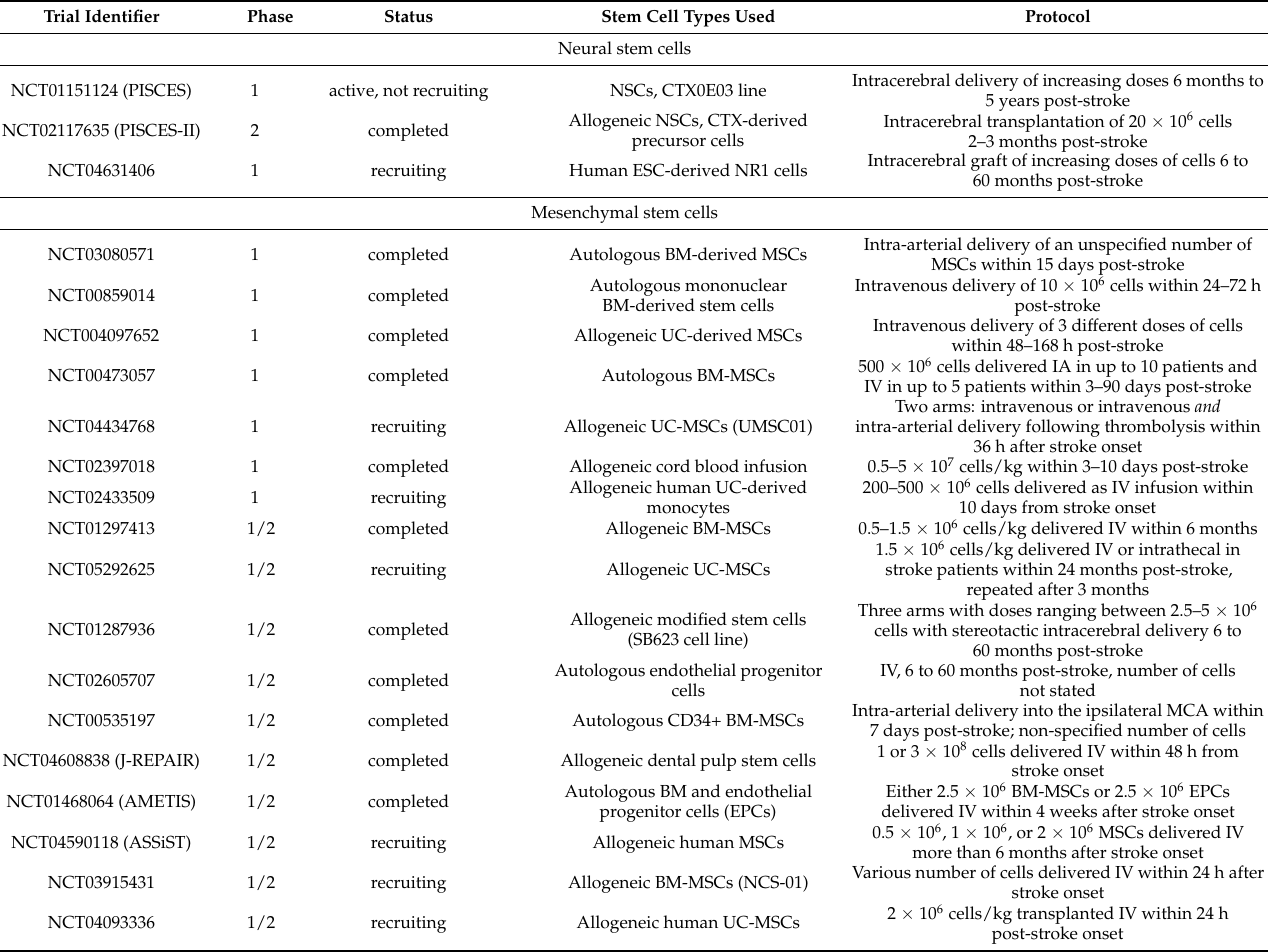
Table 3. Clinical trials using stem cell therapies for acute ischemic stroke